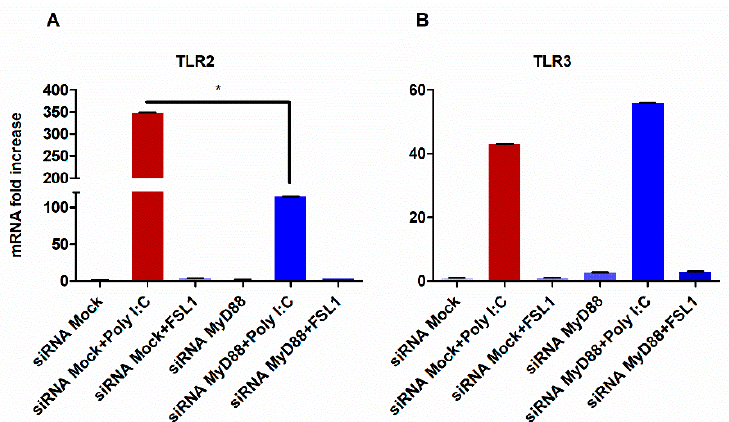
Figure 4. Upregulation of TLR2 by poly I:C is partly mediated by MyD88: when MyD88 is silenced, the expression of TLR2 is significantly decreased after the stimulation with poly I:C. ( A ). However, the silencing of Myd88 did not alter the expression of TLR3 ( B ). Statistical test: one-way ANOVA followed by Tukey’s multiple comparison test (* p < 0.05) and the results are represented as the mean ± SE ( n = 3) from three independent experiments.